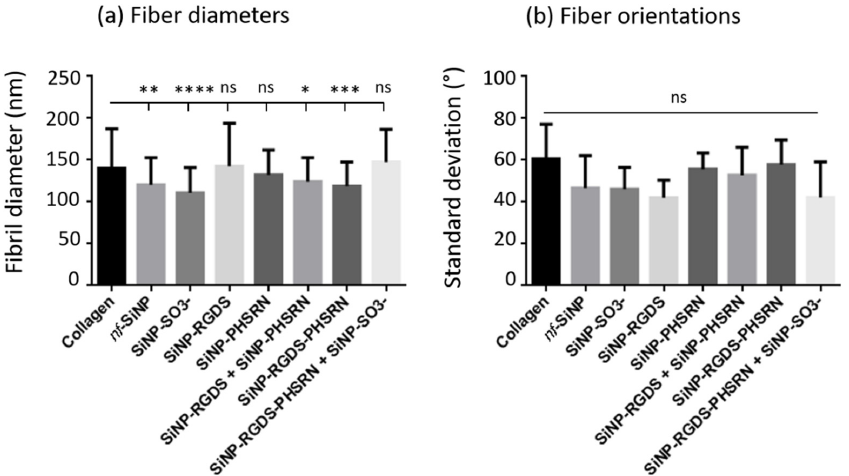
Figure 7. ( a ) Fibril diameters and ( b ) orientations measured from SEM images (performed with ImageJ software on 50 fibers for each condition). Statistical tests realized using ANOVA (Dunnett) parametric test. Each column represents mean with SEM (ns _ non-significant _ p > 0.05; * p ≤ 0.05; ** p ≤ 0.01; *** p ≤ 0.001, **** p ≤ 0.0001).